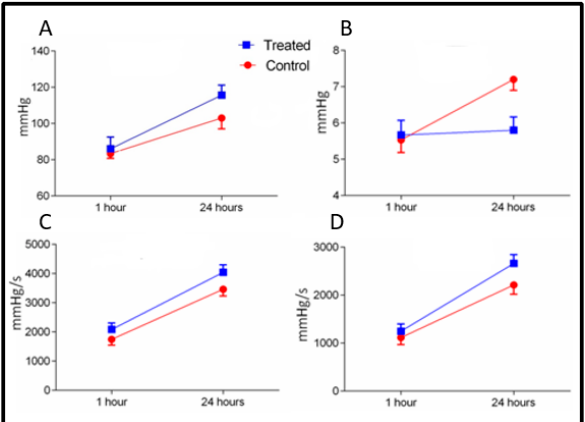
Figure 1. Hemodynamic parameters at 1 and 24 h of myocardial reperfusion in FTY720 and Control-saline treated groups. ( A ) Effect of FTY720 on LVSP, ( B ) LVEDP, ( C ) LV dP/dT max, ( D ) LV dP/dT min. Values are expressed as the means ± SD. dP/dT max: the rate of maximum positive left ventricular pressure development; dP/dT min, the rate of maximum negative left ventricular pressure development LVSP, left ventricular systolic pressure; LVEDP, left ventricular end-diastolic pressure.